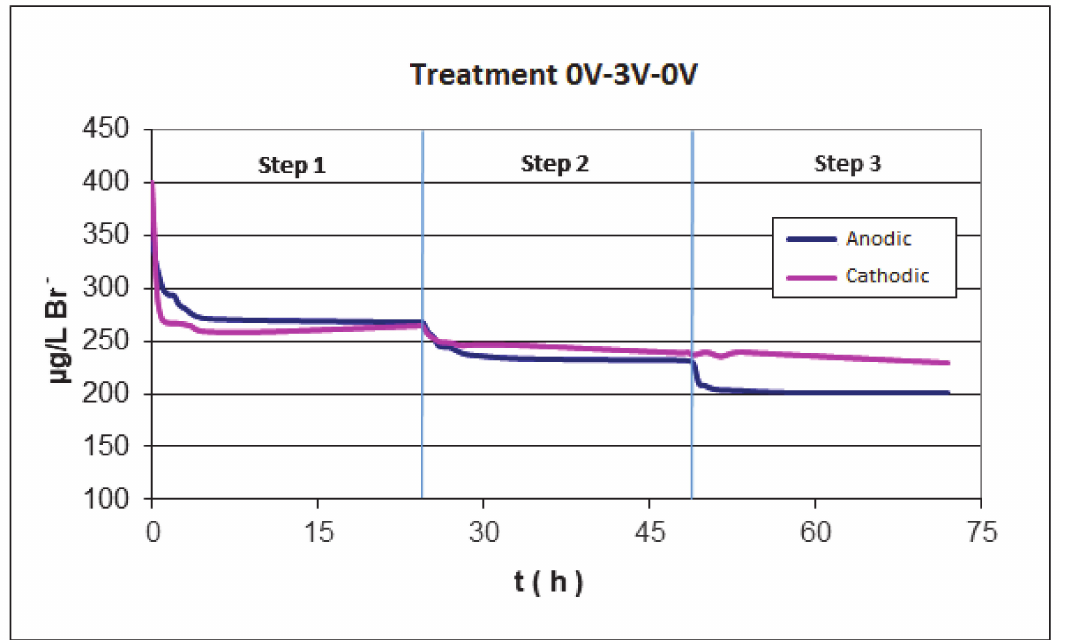
Figure 5. Bromide concentration during three steps experiment, the second corresponds to anodic and cathodic electroad- sorption experiments for 24 h at 3 V. 3 V is applied for 24 h in the second step and then it is left at open circuit again for 24 h.